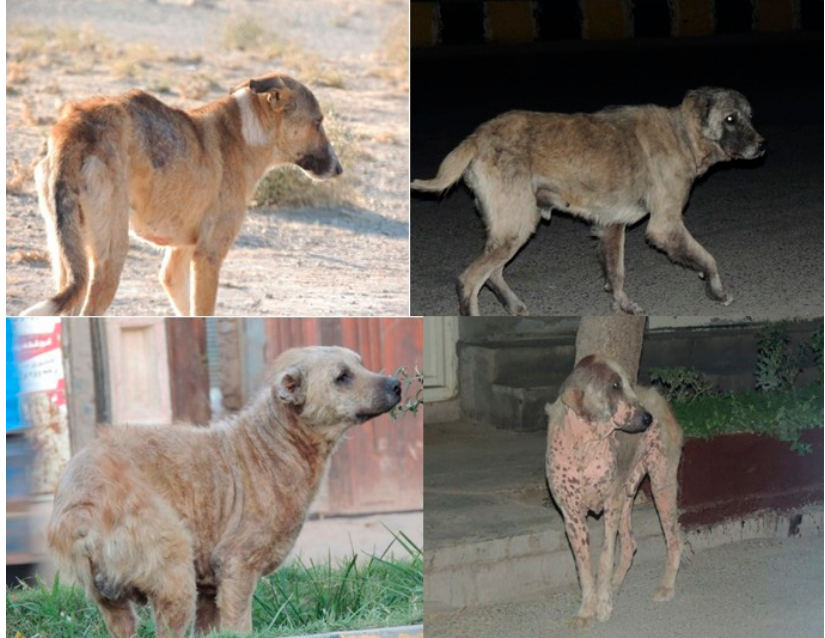
Figure 5. Selected images of dogs surveyed. Evidence of emaciation and skin lesion or dermatitis in FRDs recorded in Herat city.